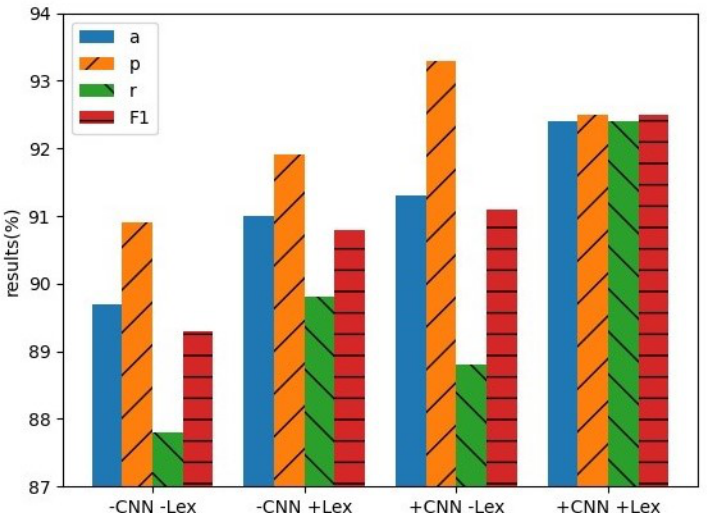
Figure 8. Comparison model experiment